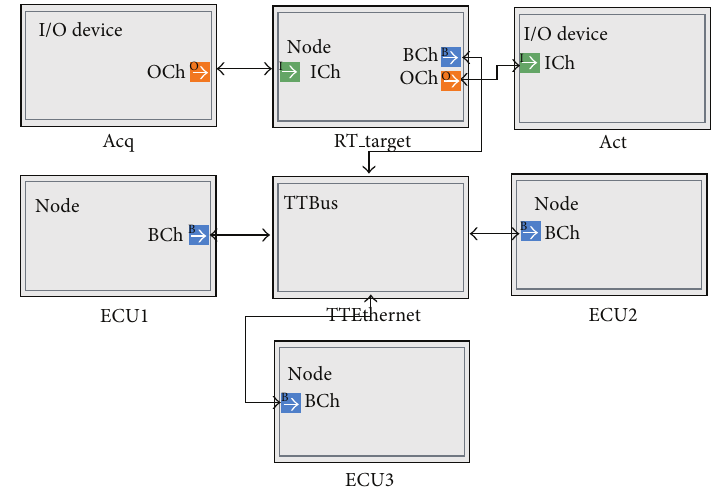
Figure 9: Hardware platform representation of the experimental platform.